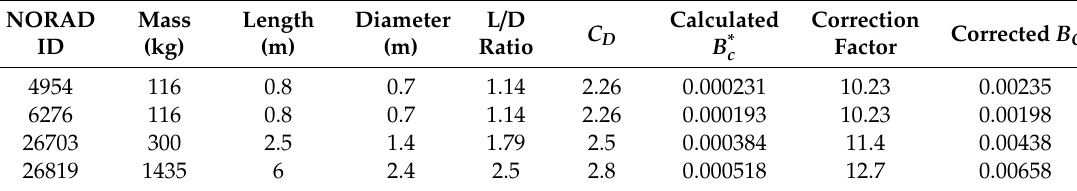
Table 7. The list of initial B C